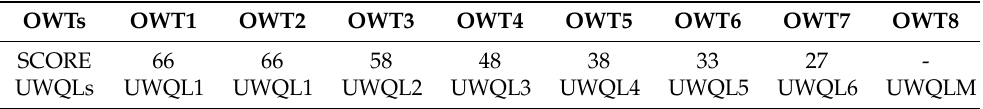
Table 2. Water quality grading results of the